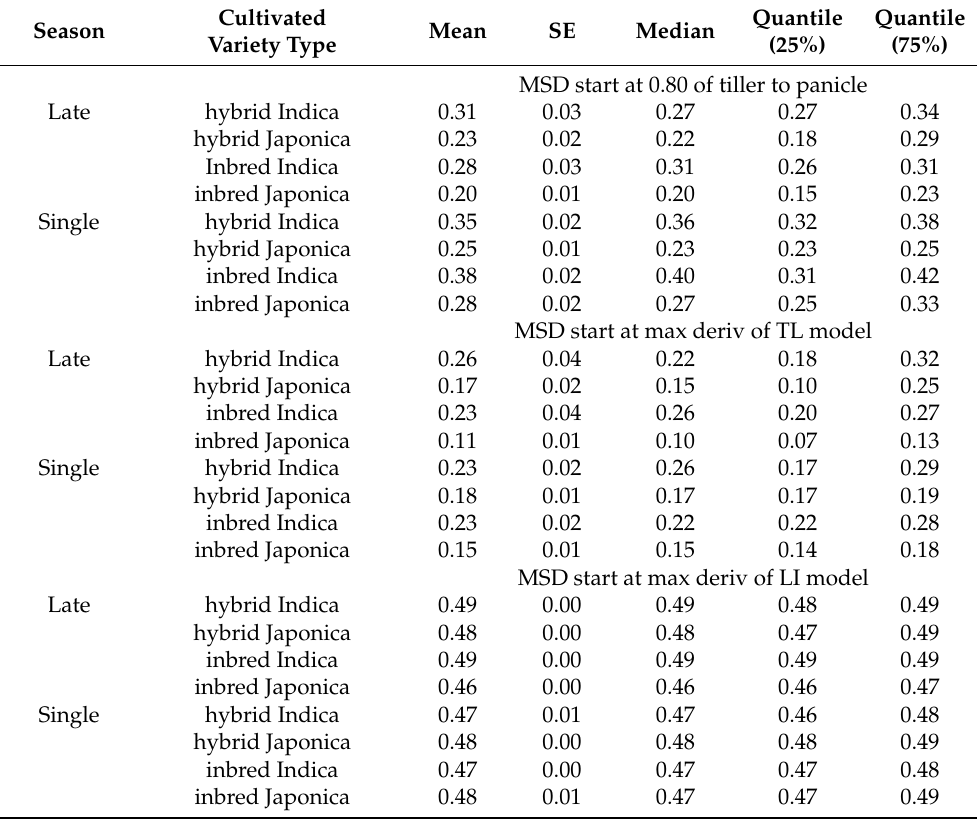
Table 2. Summary statistics for the CLI value of MSD initiation of different